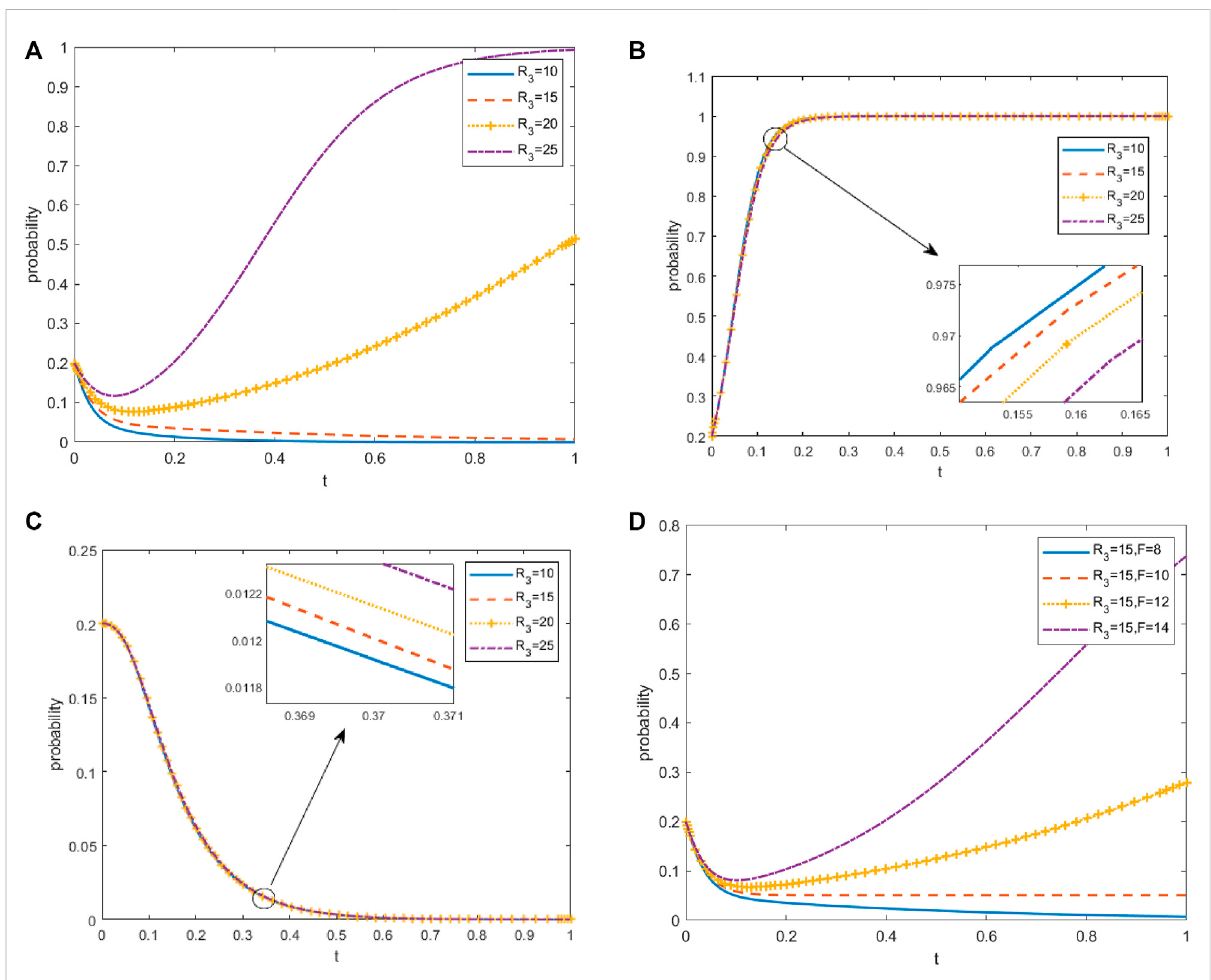
FIGURE 14 Effect of R 3 on the evolution of the system. (A) Effect of R 3 on farmer ’ s strategy, (B) Effect of R 3 on the local government ’ s strategy, (C) Effect of